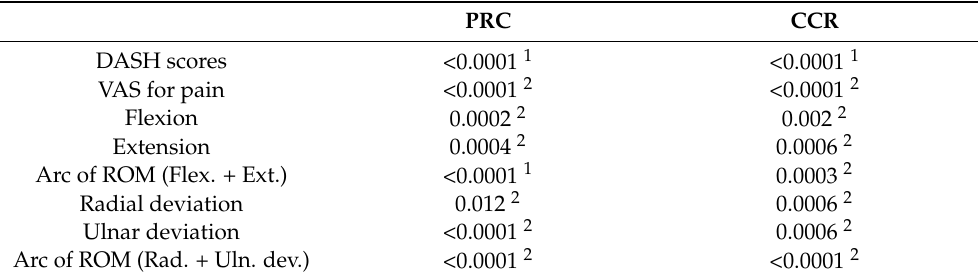
Table 4. P -values resulting from the comparison between pre- and postoperative outcomes within every group. PRC CCR DASH scores <0.0001 1 <0.0001 1 VAS for pain <0.0001 2 <0.0001 2 Flexion 0.0002 2 0.002 2 Extension 0.0004 2 0.0006 2 Arc of ROM (Flex. + Ext.) <0.0001 1 0.0003 2 Radial deviation 0.012 2 0.0006 2 Ulnar deviation <0.0001 2 0.0006 2 Arc of ROM (Rad. + Uln. dev.) <0.0001 2 <0.0001